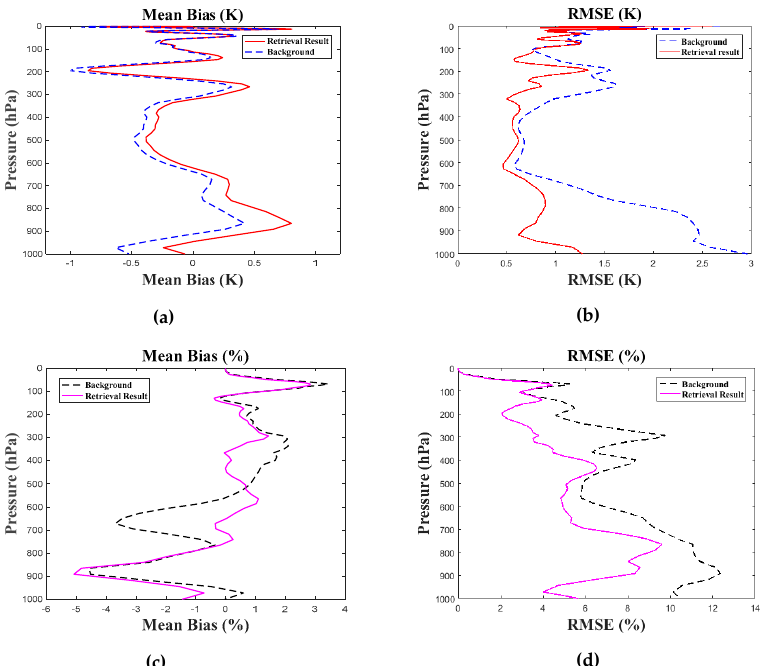
Figure 11. ( a , b ) The MB and RMSE of the temperature profile, respectively. ( c , d ) The MB and RMSE of the humidity profile, respectively. The red solid line represents the comparison between the inversion results and the ERA-Interim data, while the blue dotted line represents the comparison between the background field profile and the ERA-Interim data.